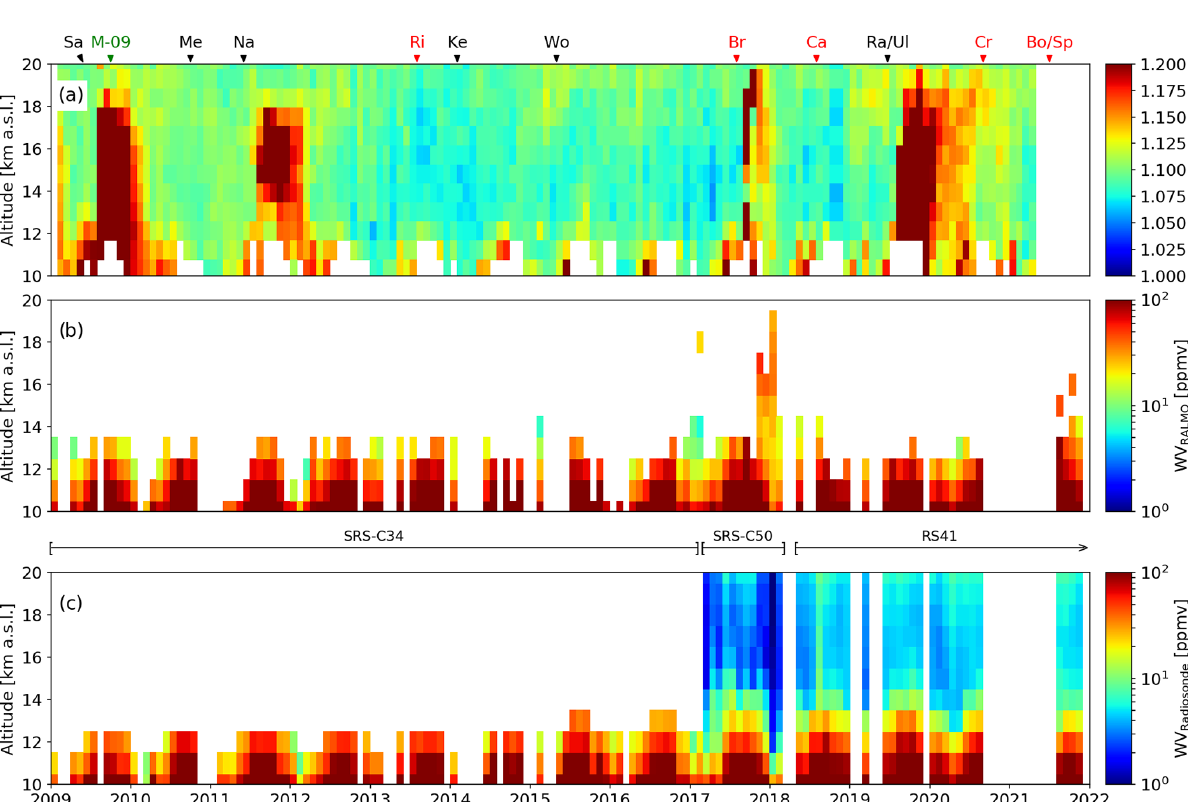
Figure 2. (a) Monthly and zonally averaged time series of aerosol scattering ratio derived from CALIOP between 2009 and the end of 2021 at 45–50 ◦ N (Payerne). Major eruptions (black triangles), PyroCb events (red triangles), and the MOHAVE-2009 field campaign (green triangle) are indicated at the top of the plot (see Table 1). (b) Monthly averaged RALMO water vapor mixing ratio measurements during days where radiosonde launches were available. (c) Monthly averaged radiosonde water vapor mixing ratio. The periods where the SRS-C34, SRS-C50, and RS41 radiosondes were used are indicated on top of the